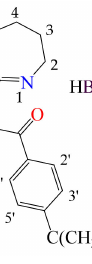
Figure 12. Compound 2d